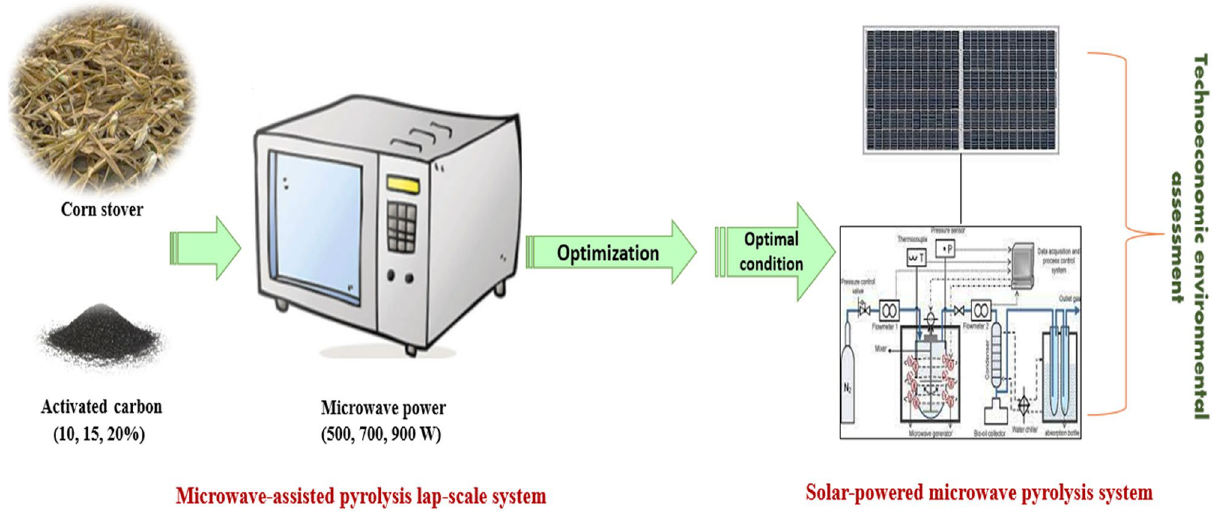
Figure 1. The experimental scheme of